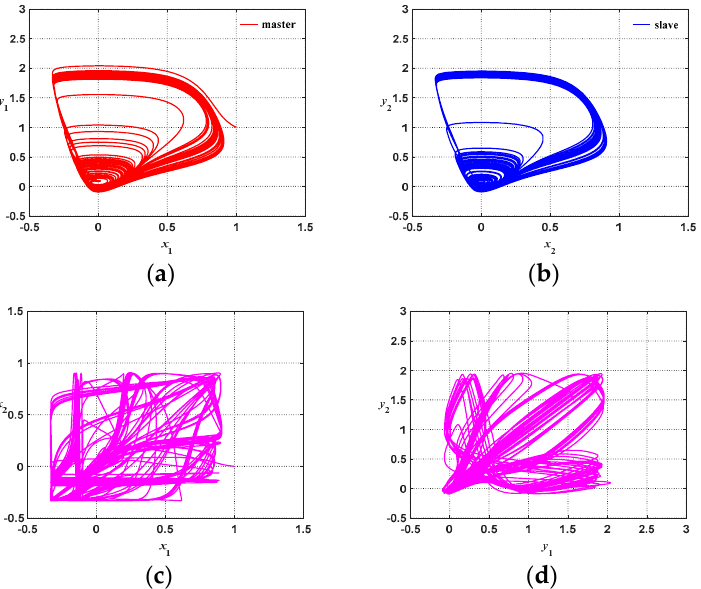
Figure 10. Uncontrolled coupled nonlinear chaotic system ( g = 0.01): ( a ) Master system phase diagram; ( b ) Slave system phase diagram; ( c ) x 1 , x 2 phase diagram; ( d ) y 1 , y 2 phase diagram.